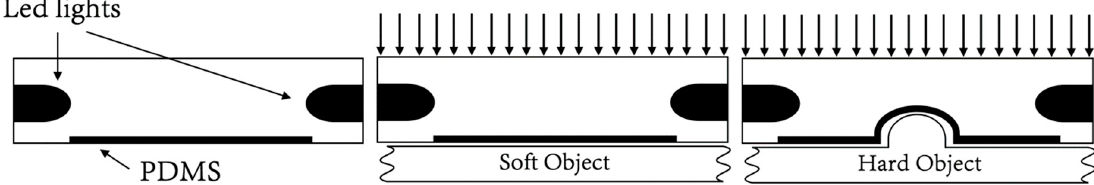
Figure 7. Deformation of PDMS when the waveguide is penetrated by a hard object.